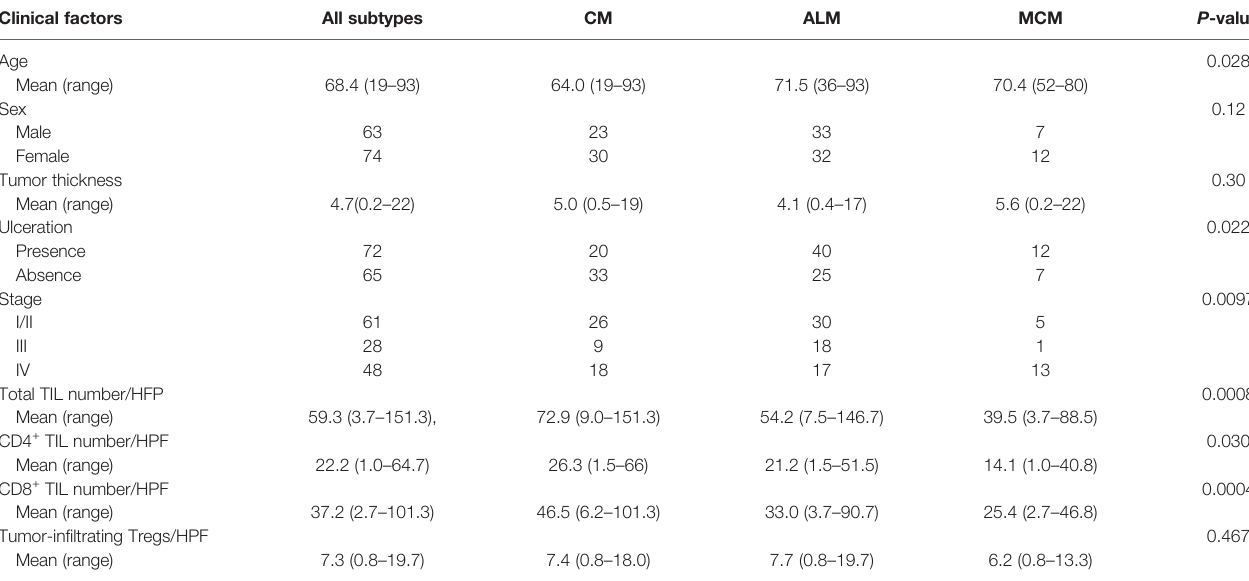
TABLE 1 | Patients ’ background and data for each melanoma subtype. Clinical